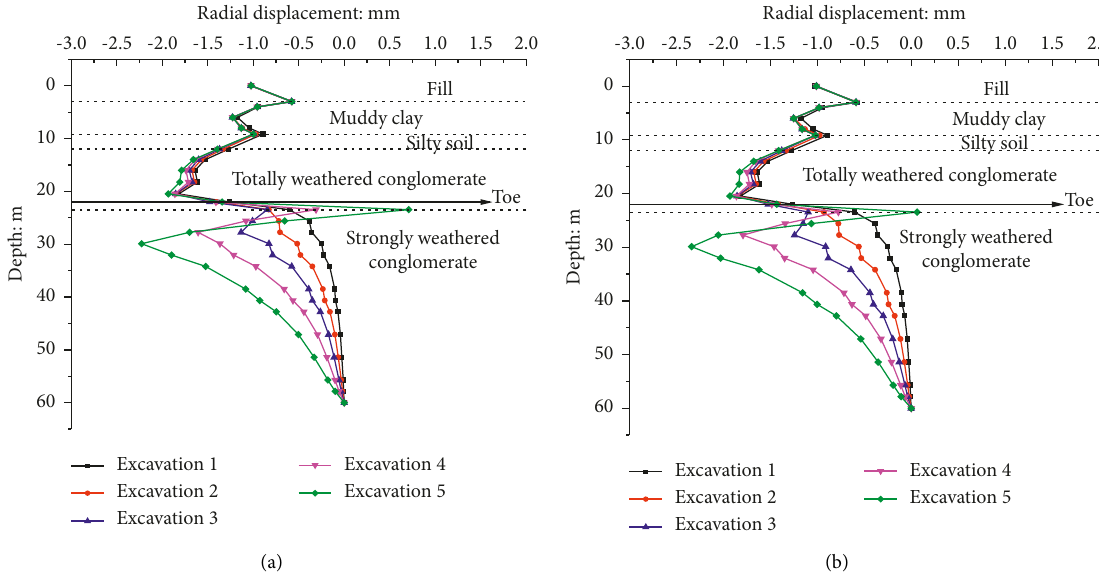
Figure 18: Radial displacement distribution behind the wall with a depth at the center of Gutter 7 after soil excavation:effect of construction method. (a) Smooth practice. (b) Inverse method.